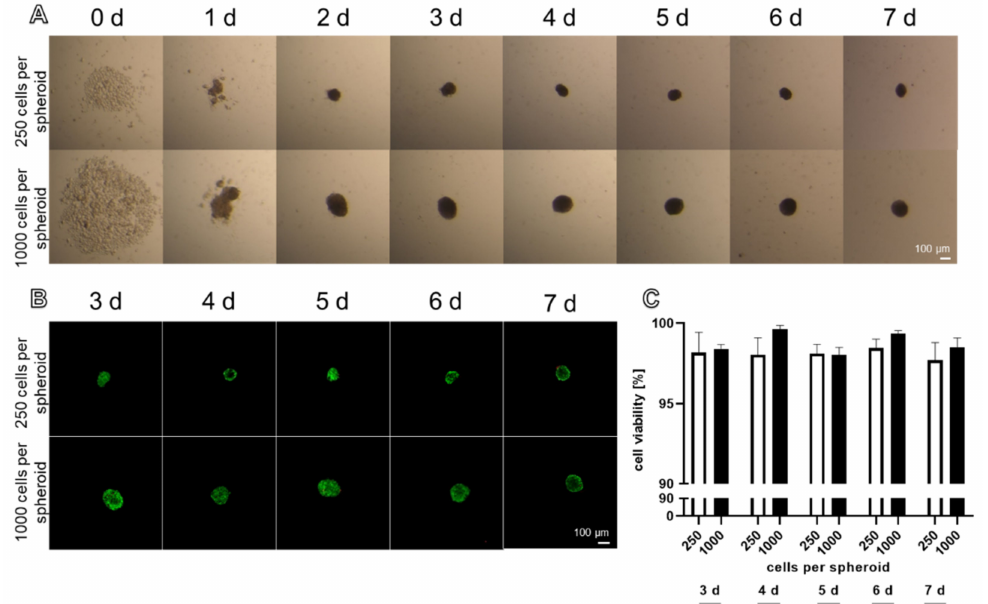
Figure 1. Ligamentocyte spheroid formation and viability based on 250 and 1000 cells per spheroid documented over 7 days using the hanging drop method. ( A ) Invert microscopical images of the same spheroids over 7 days. ( B ) Viability of cells cultured in spheroids prepared by the hanging drop method. Dead cells are red stained with propidium iodide and living cells are green due to metabolizing fluorescein diacetate. Scale bars: 100 µ m ( A , B ). ( C ) Viability was monitored by CLSM after 3 to 7 days and calculated using ImageJ. Statistics: n = 3 independent experiments were performed with cells of five different donors. One-way ANOVA (Tukey’s multiple comparisons test) for comparison between groups ( C ).